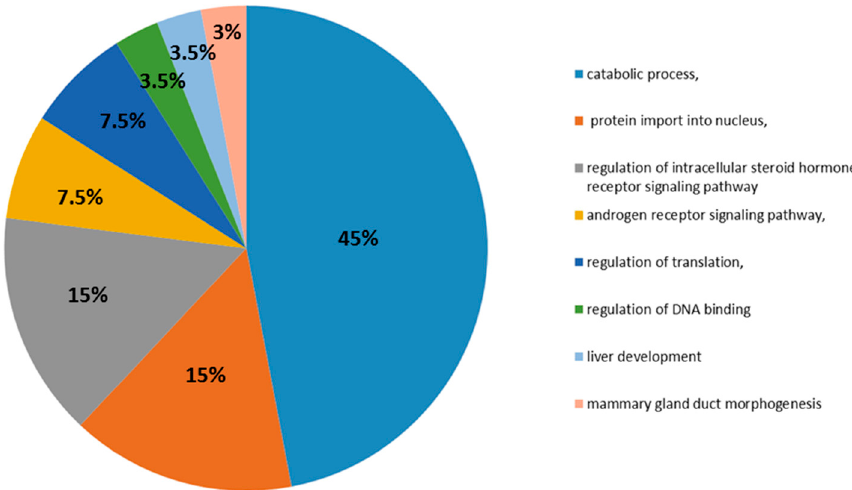
Figure 3. ClueGo analysis. In terms of biological processes, the top categories are regulation of the protein catabolic process, protein import into the nucleus, regulation of the intracellular steroid hormone receptor signaling pathway, regulation of the androgen receptor signaling pathway, regulation of translation, regulation of DNA binding, liver development and mammary gland duct morphogenesis.